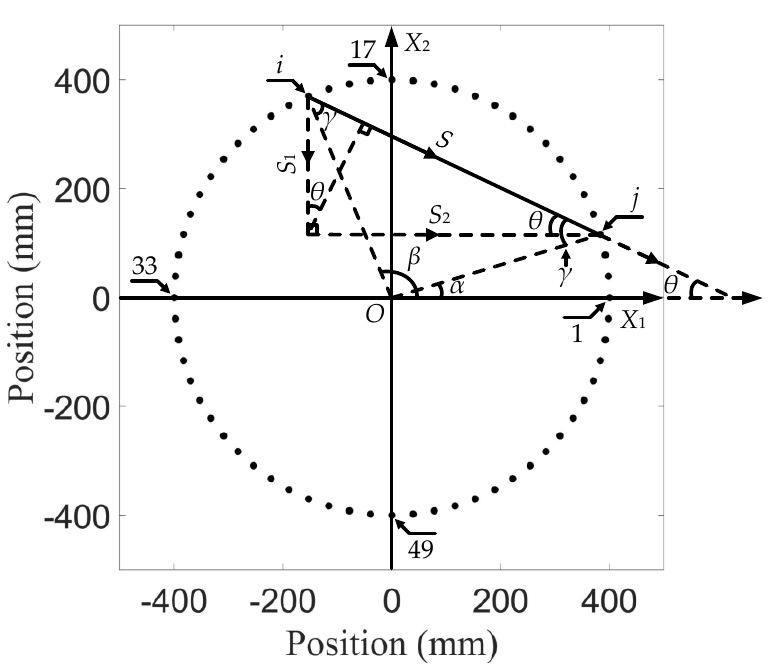
Figure 6. Trigonometric operations of the in-plane reception when the vector of an excitation–reception pair, i–j , is towards Quadrant IV of the coordinate system. Using the internal angle of the special triangle formed by the array origin and the two sensors, the X 1 direction signal, S 1 , and the X 2 direction signal, S 2 , are combined into the actuation–reception direction signal, S .